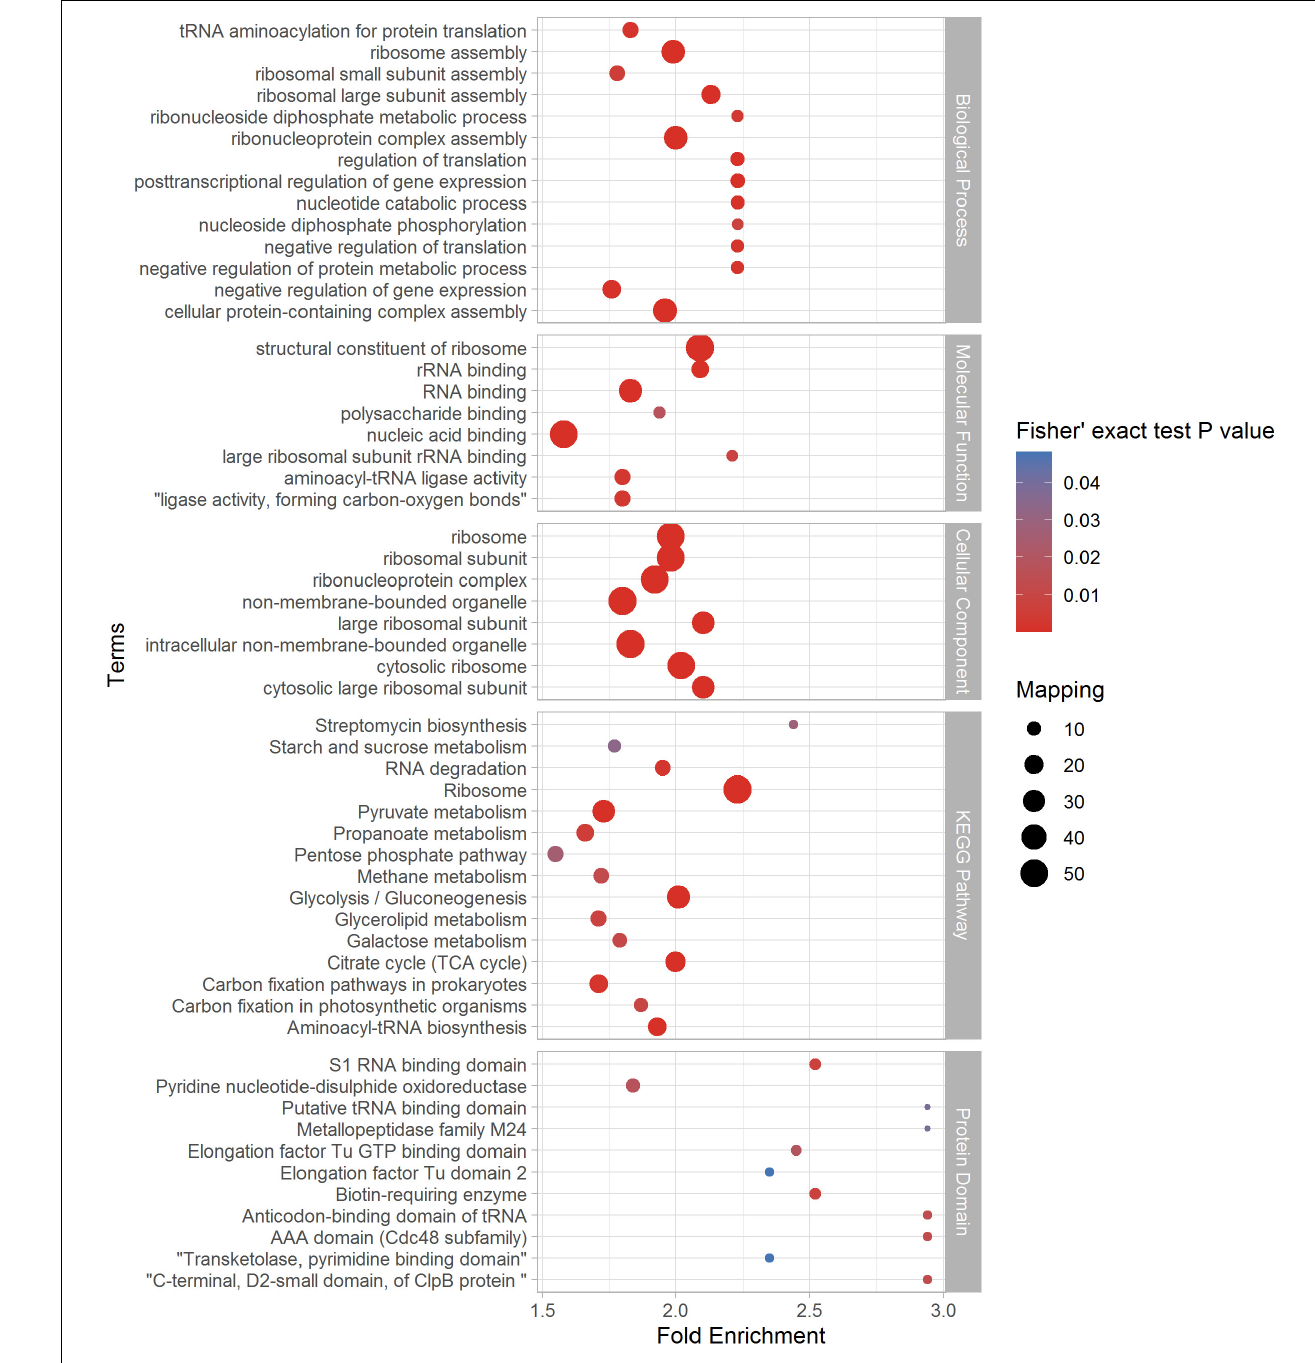
FIGURE 4 | Enrichment analysis of identified succinylproteins in terms of biological process (BP), molecular function (MF), cellular component (CC), KEGG pathway, and protein domain ( p < 0.05).